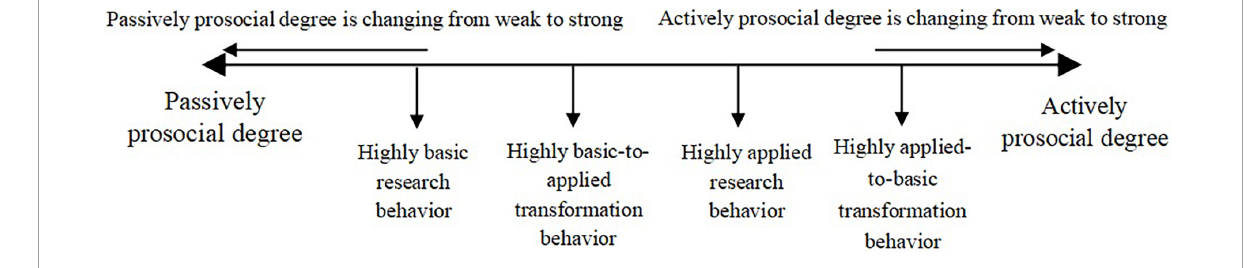
FIGURE2 Active and passive prosocial levels of different types of high innovation